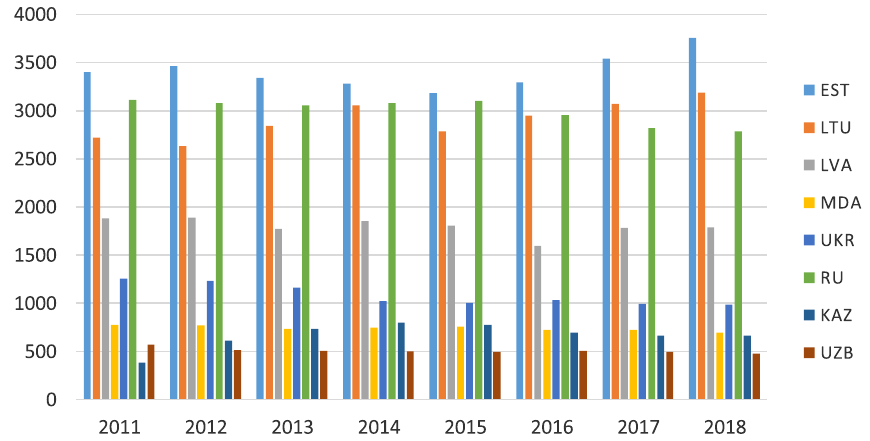
Figure 3. Researchers in R&D (per million people) in post-Soviet countries in 2011–2018.